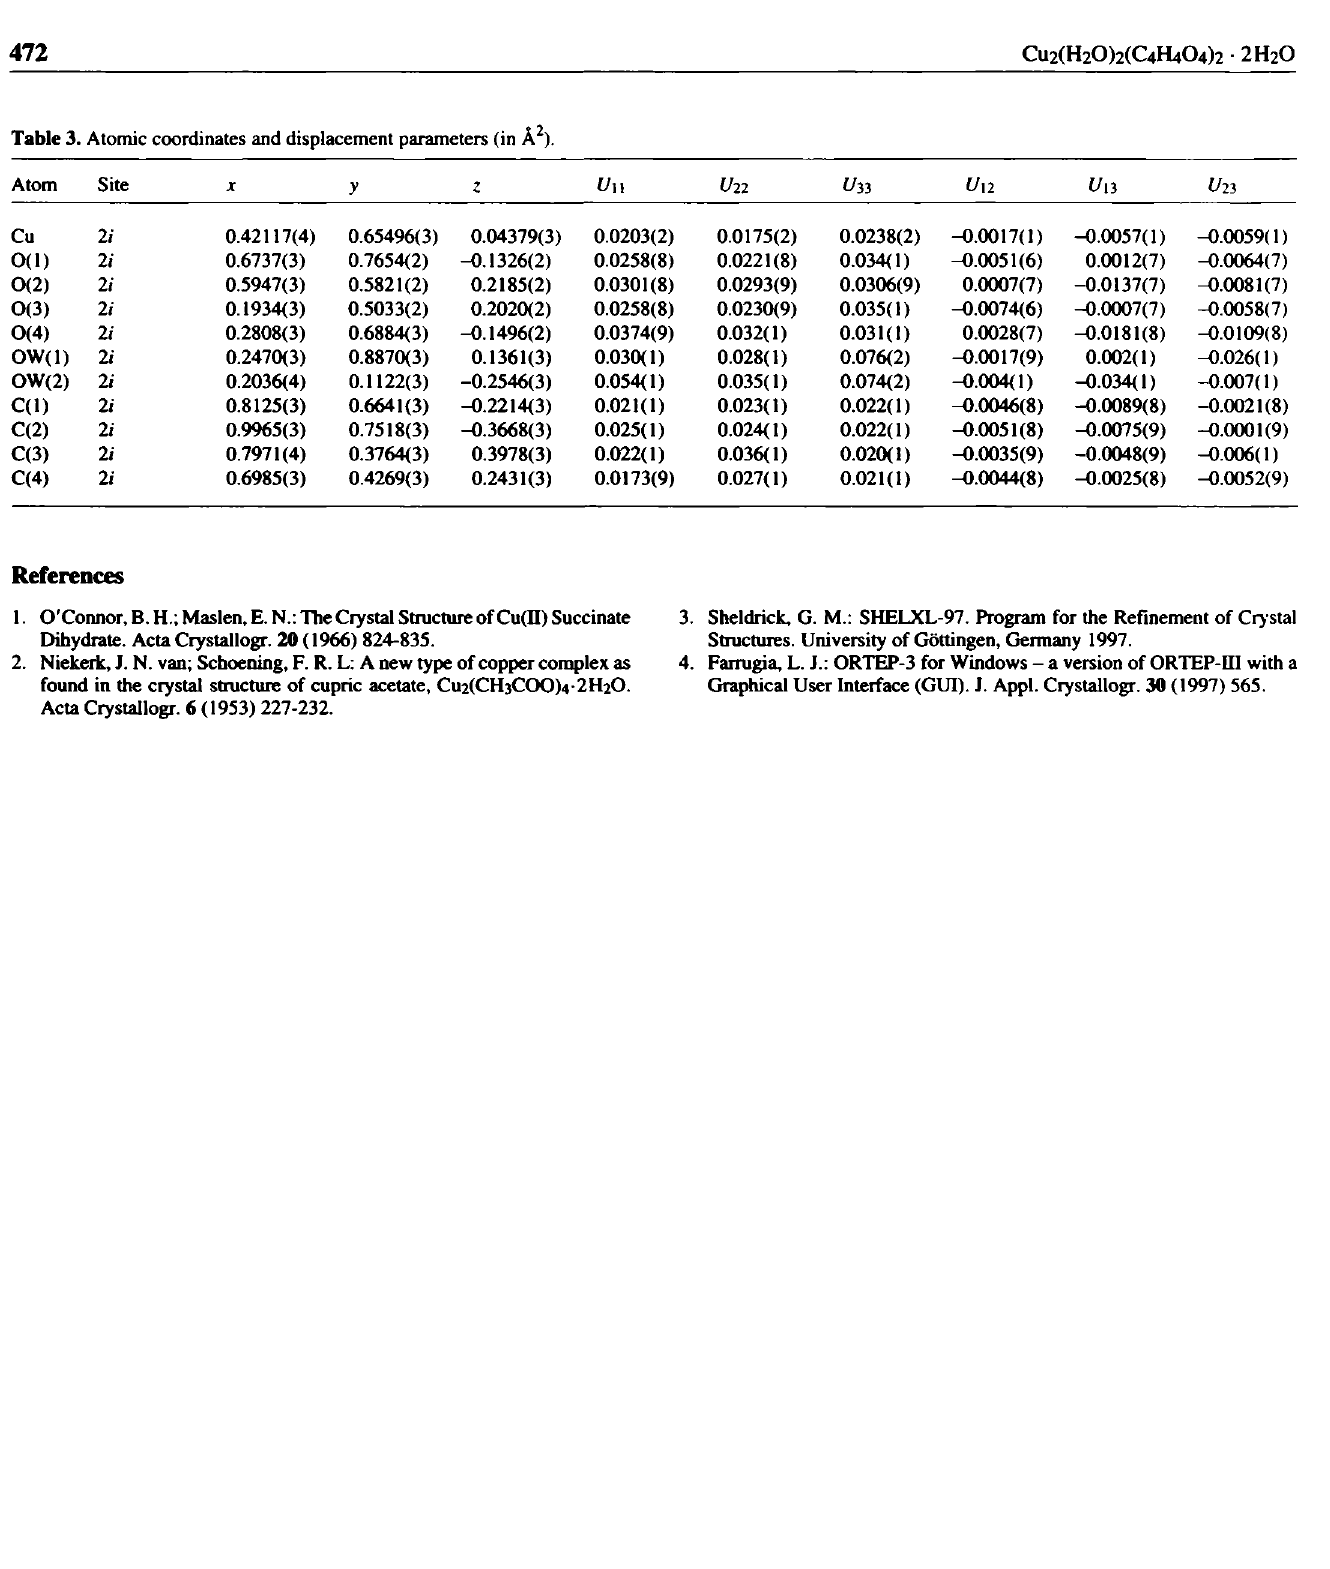
Table 3. Atomic coordinates and displacement parameters (in Â 2